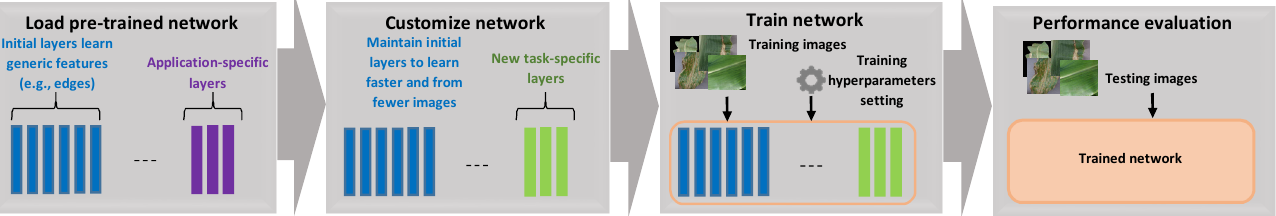
Figure 1. The general steps taken to build the corn disease classification